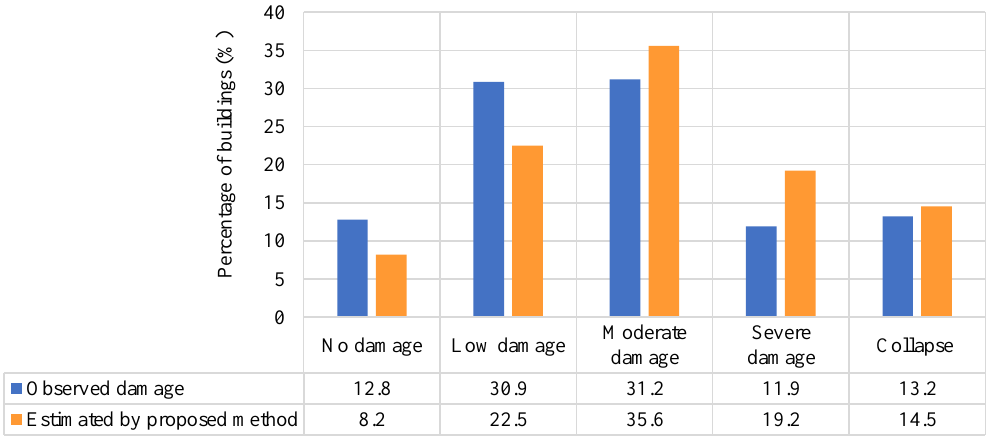
Figure 5. Damage state of selected building data of